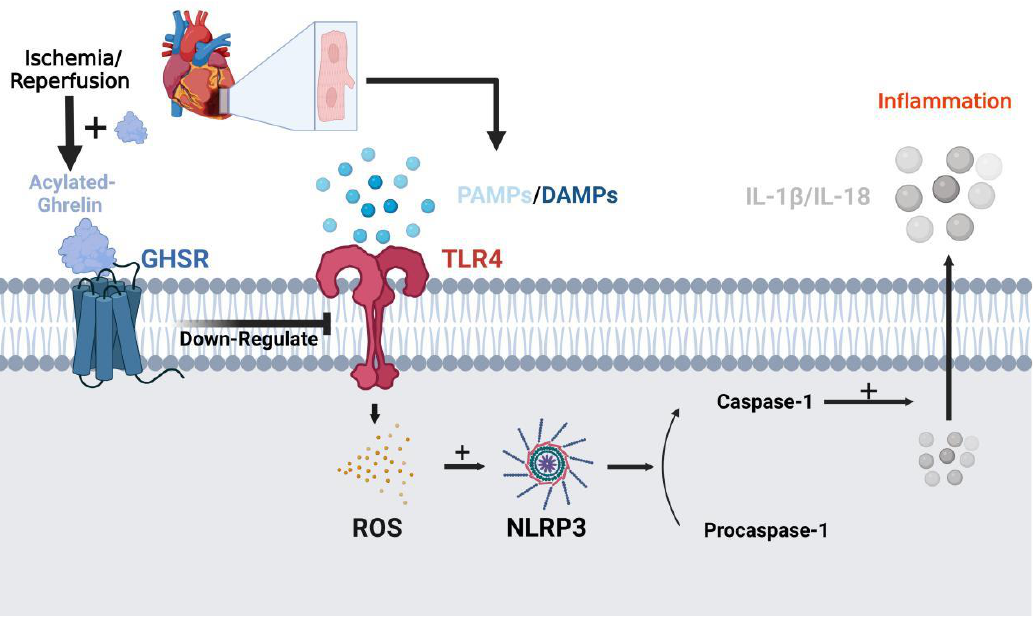
Figure 3. TLR4/NLRP3 signaling pathway inhibition by acylated-ghrelin to reduce I/R-induced cardiomyocyte infarction and inflammation. During myocardial I/R injury, TLR4 is expressed on the surface of the myocardial cell membrane, and PAMPs and DAMPs bind to it to release ROS. ROS activates NLRP3 inflammasome, which in turn promotes the activation of procaspase-1 to caspase-1. Caspase-1 promotes the release of inflammatory factors IL-1 β and IL-18 from the cell and triggers the inflammatory response. Ghrelin can downregulate the expression of TLR4, thereby inhibiting the occurrence of the inflammatory response and alleviating myocardial injury caused by I/R. TLR4, Toll-like receptor 4; PAMPs, Pathogen-associated molecular patterns; DAMPs, damage associated molecular patterns; ROS, reactive oxygen species; NLRP3, NOD-like receptor thermal protein domain associated protein 3; IL- 1β&IL - 18, interleukin 1β&interleukin 18. Created with BioRender.com.